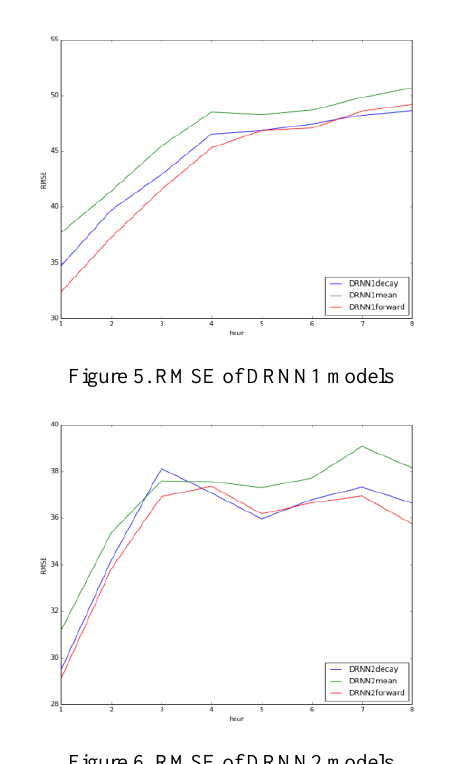
Figure 8. RMSE of models based on mean-fix